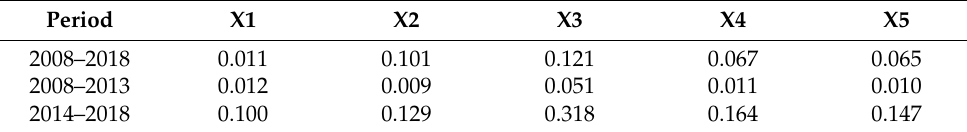
Table 5. The q statistics of external factors based on GeoDetector. Period X1 X2 X3